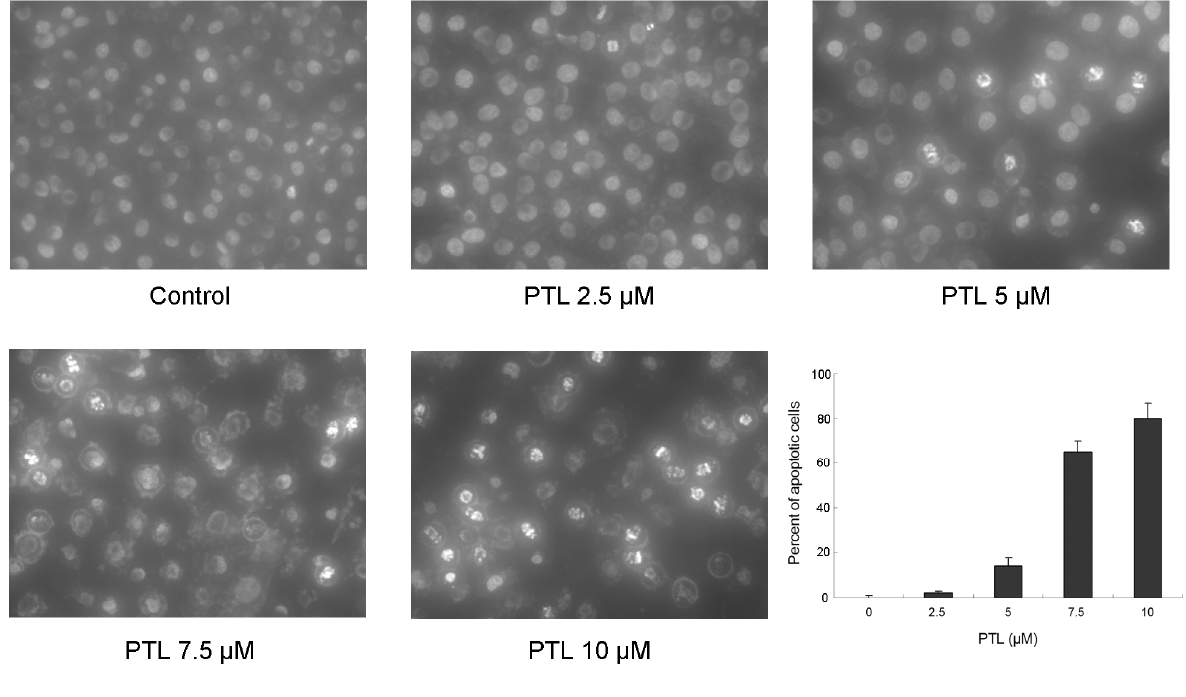
Figure 2. Detection of apoptosis after exposure to parthenolide for 48 h in 5637 bladder cancer cells. Cells were stained with Hoechst stain (H33258), visualized by UV microscopy, and quantitated by counting condensed and fragmented nuclei in five randomly selected areas. The proportion of apoptotic cells was expressed as a